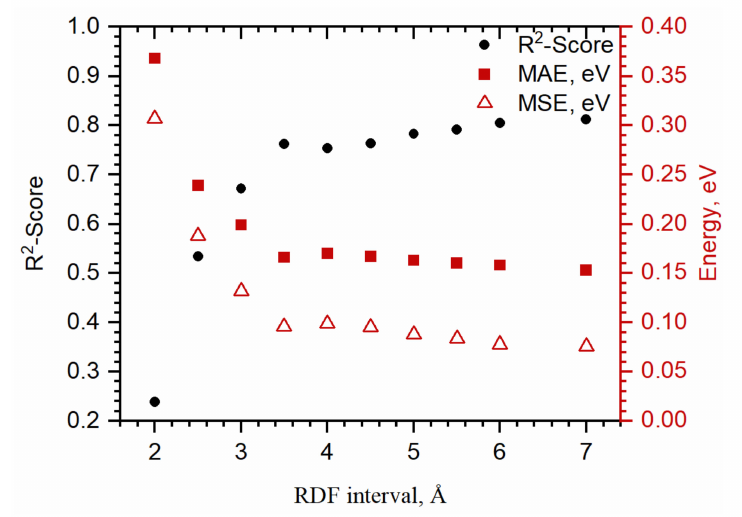
Figure 4. The quality of binding-energy prediction when using a different length of RDF.